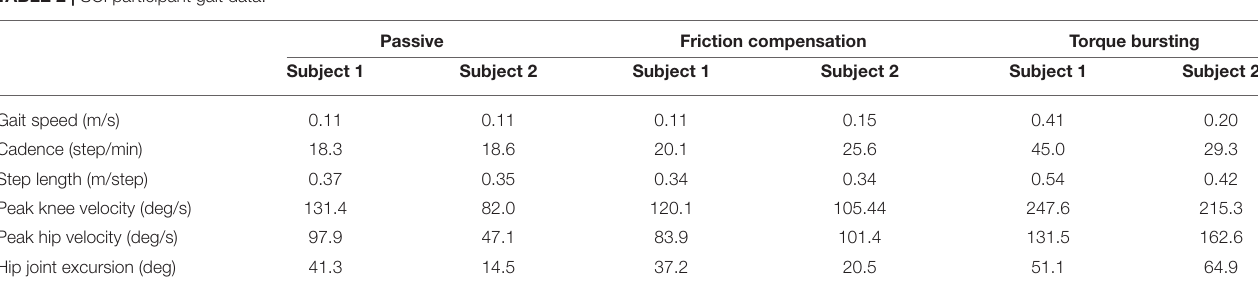
TABLE 2 | SCI participant gait